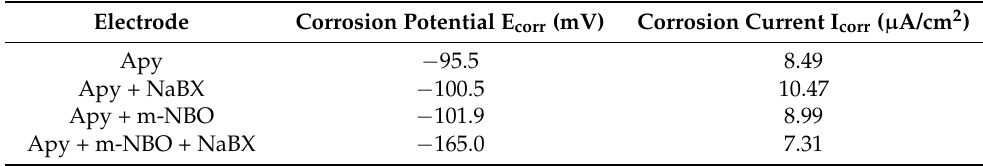
Table 4. The Tafel parameters of the electrode in the pH = 9 solution were studied (0.3 mol/L